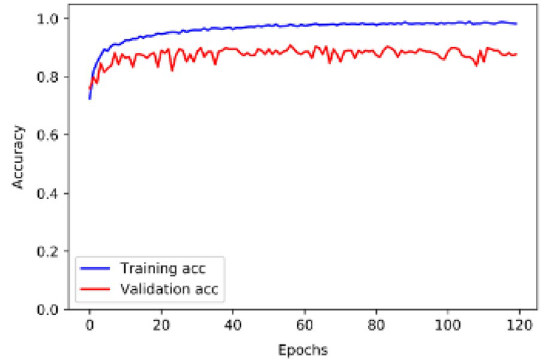
Fig. 9 Transfer learning experiment